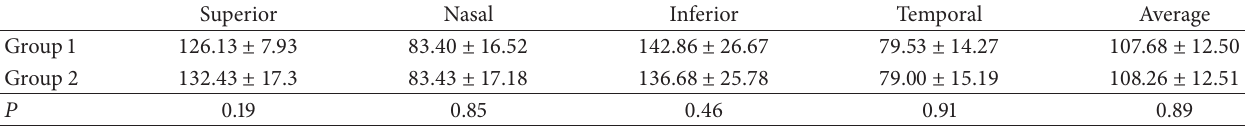
Table 4: According to average oxygen saturation RNFL thickness ( 𝜇 ) of patients with OSAS (cut off value 90%).